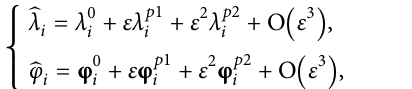
Figure 6: The flowchart of the damage identification